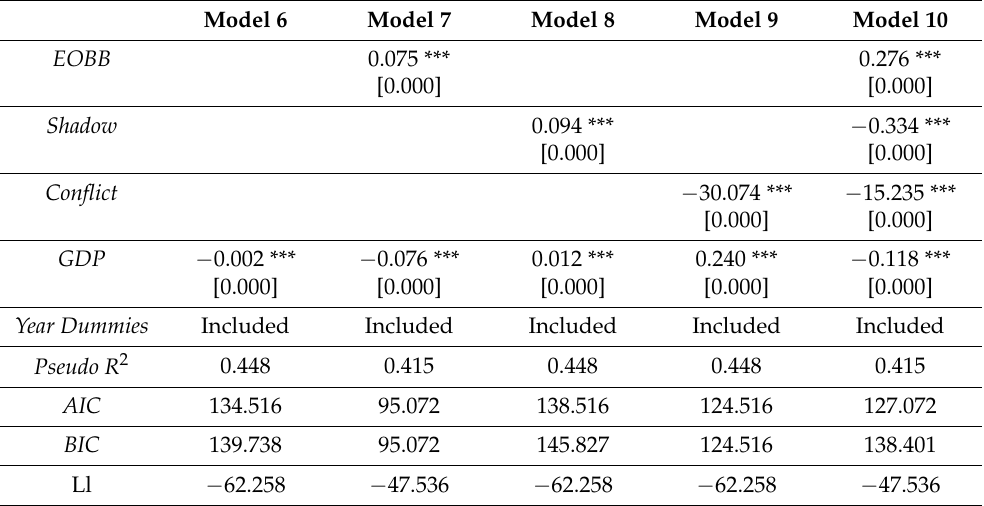
Table 5. Number of deals involving Ukrainian targets by domestic